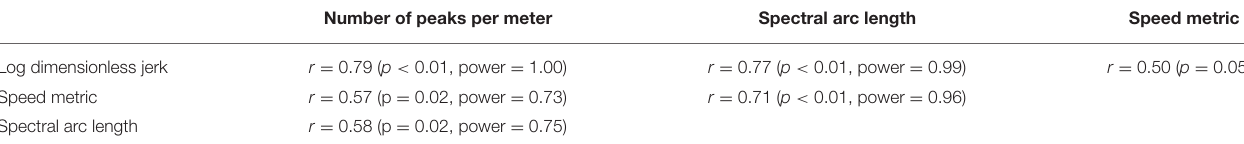
TABLE 5 | Correlations between the four different smoothness parameters. Number of peaks per meter Spectral arc